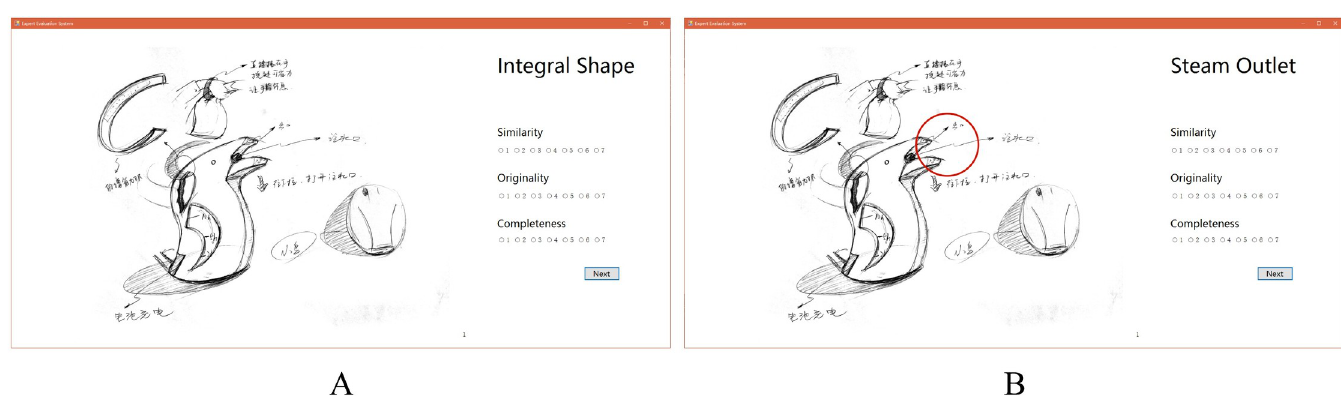
Fig 2. Interface of the Evaluation System (A: Evaluation of integral shape; B: Evaluation of local shapes (steam outlet)).